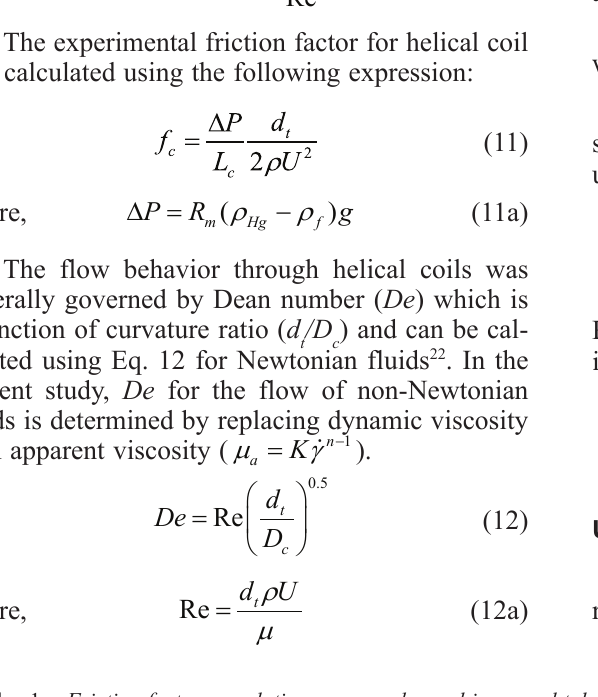
Table 1 – Friction factor correlations commonly used in curved tubes under different flow conditions Reference Proposed Correlation